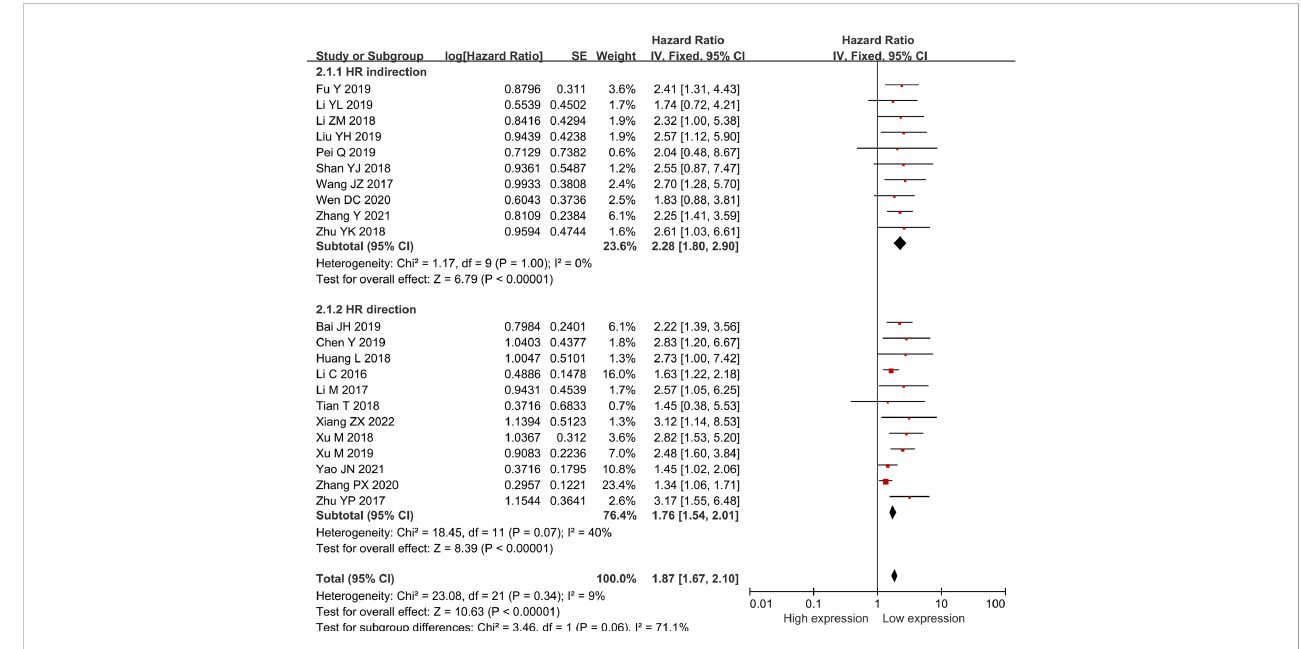
FIGURE 2 Forest plot showing the relationship between small nucleolar RNA host gene expression and overall survival (OS) in colorectal cancers.